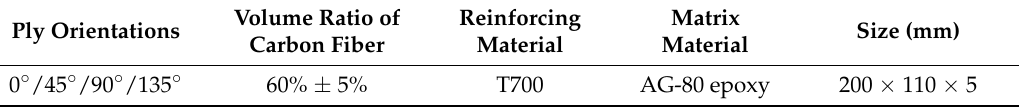
Table 3. Structural parameters of the multidirectional carbon fiber composite